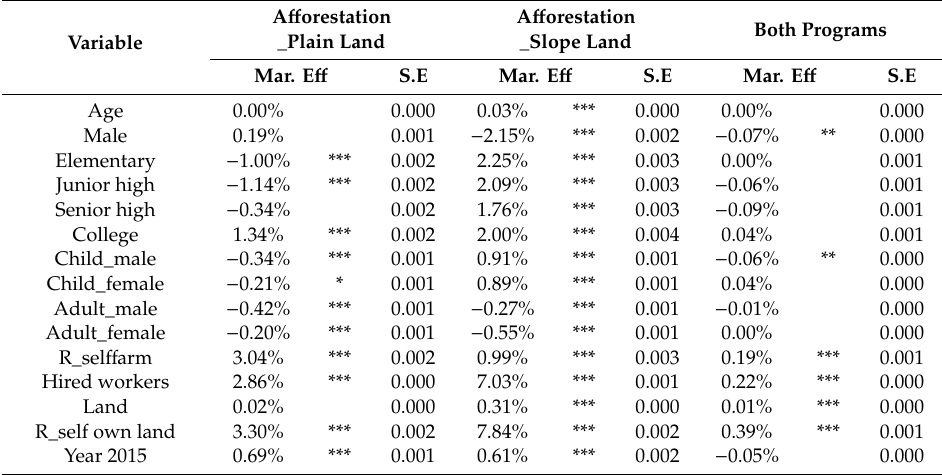
Table 3. Estimated marginal e ff ects of the multinomial logit